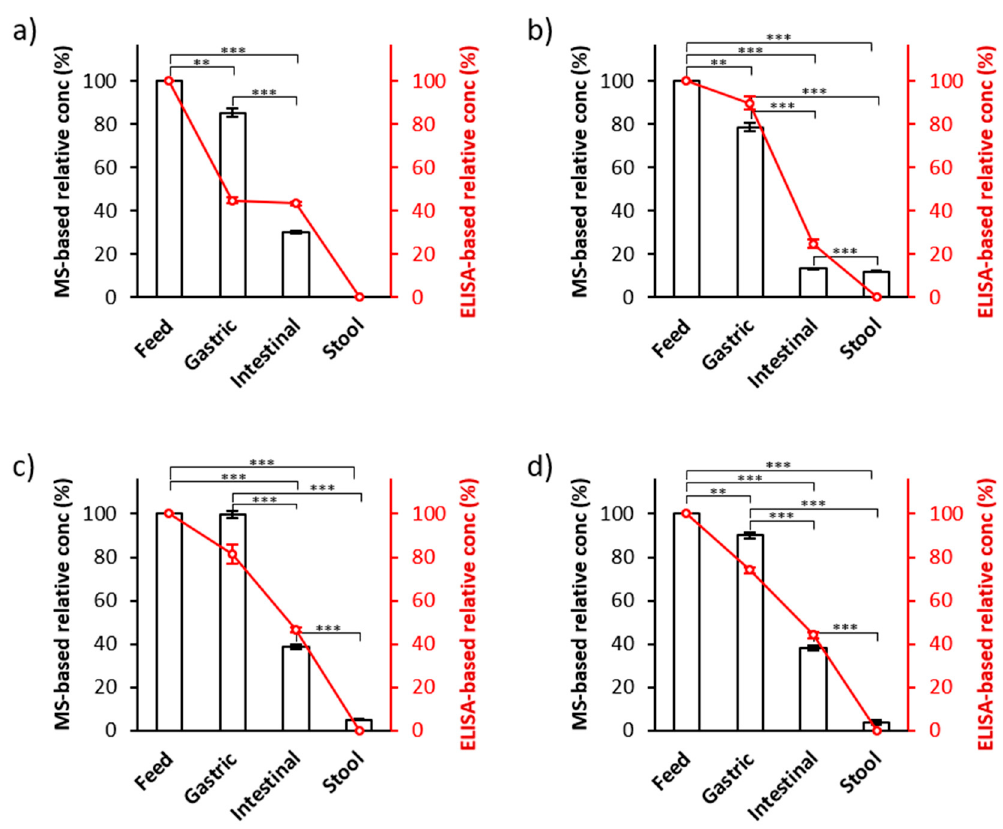
Figure 4. The relative quantitation of palivizumab in feed, gastric, intestinal and stool samples of: ( a ) infant 1; ( b ) infant 2; ( c ) infant 3; and ( d ) infant 4 measured by PRM-MS and ELISA. The bar graphs (white) and line charts (red) display the relative concentration of palivizumab as measured by PRM-MS and ELISA, respectively. The relative concentrations of intact palivizumab in gastric, intestinal and stool samples were normalized against the absolute concentration measured in each feed. p -Values of normalized concentrations of PRM-quantitation were calculated by paired Student’s t -test. * (one asterisk), ** and *** indicate p < 0.05, < 0.01 and < 0.001, respectively.